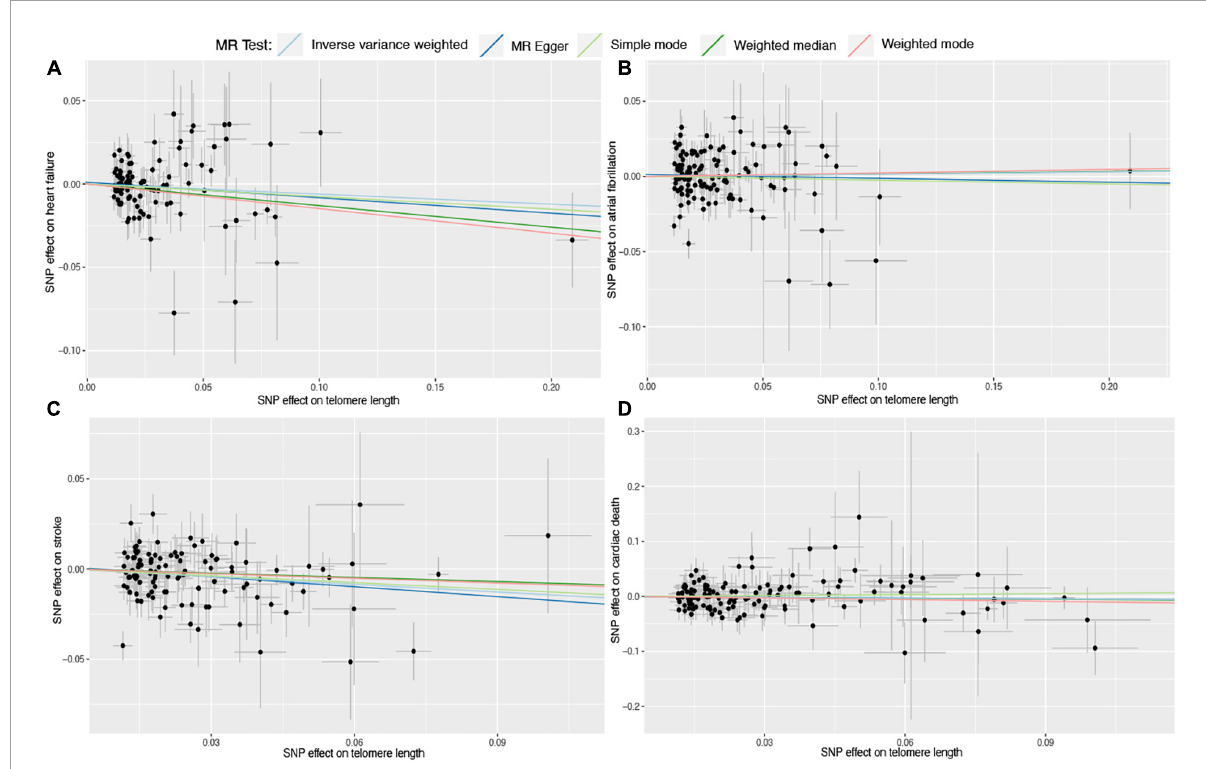
FIGURE4 Scatter plots for Mendelian randomization (MR) analyses of the correlation between telomere length (TL) and cardiovascular diseases (CVDs). (A) TL-heart failure; (B) TL-atrial fibrillation; (C) TL-stroke; (D) TL-cardiac death. The slope of each line corresponds to the estimated association effect between TL and the risk of CVDs of different MR